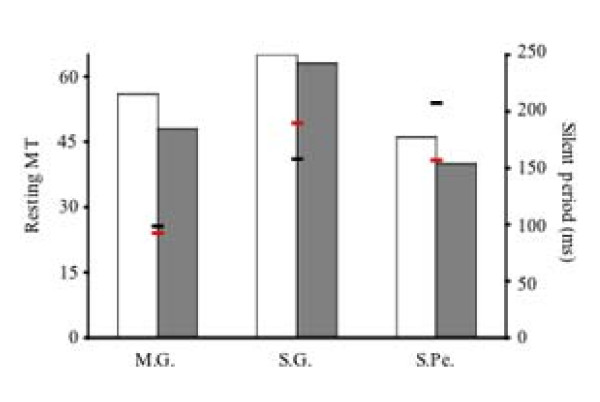
Resting motor threshold values and silent period duration for the patients. Primary Y-axis: averaged motor thresholds for each patient (% maximum stimulator output). White and gray columns show the motor threshold for the left and right hemisphere, respectively. Secondary Y-axis: silent period duration for each patient. Black lines show silent period duration in ms.